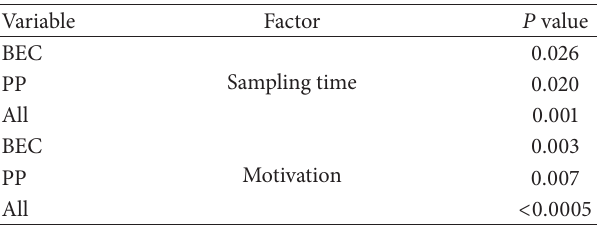
Table 3: Evaluation of positivity variance in relation to sampling time and motivation